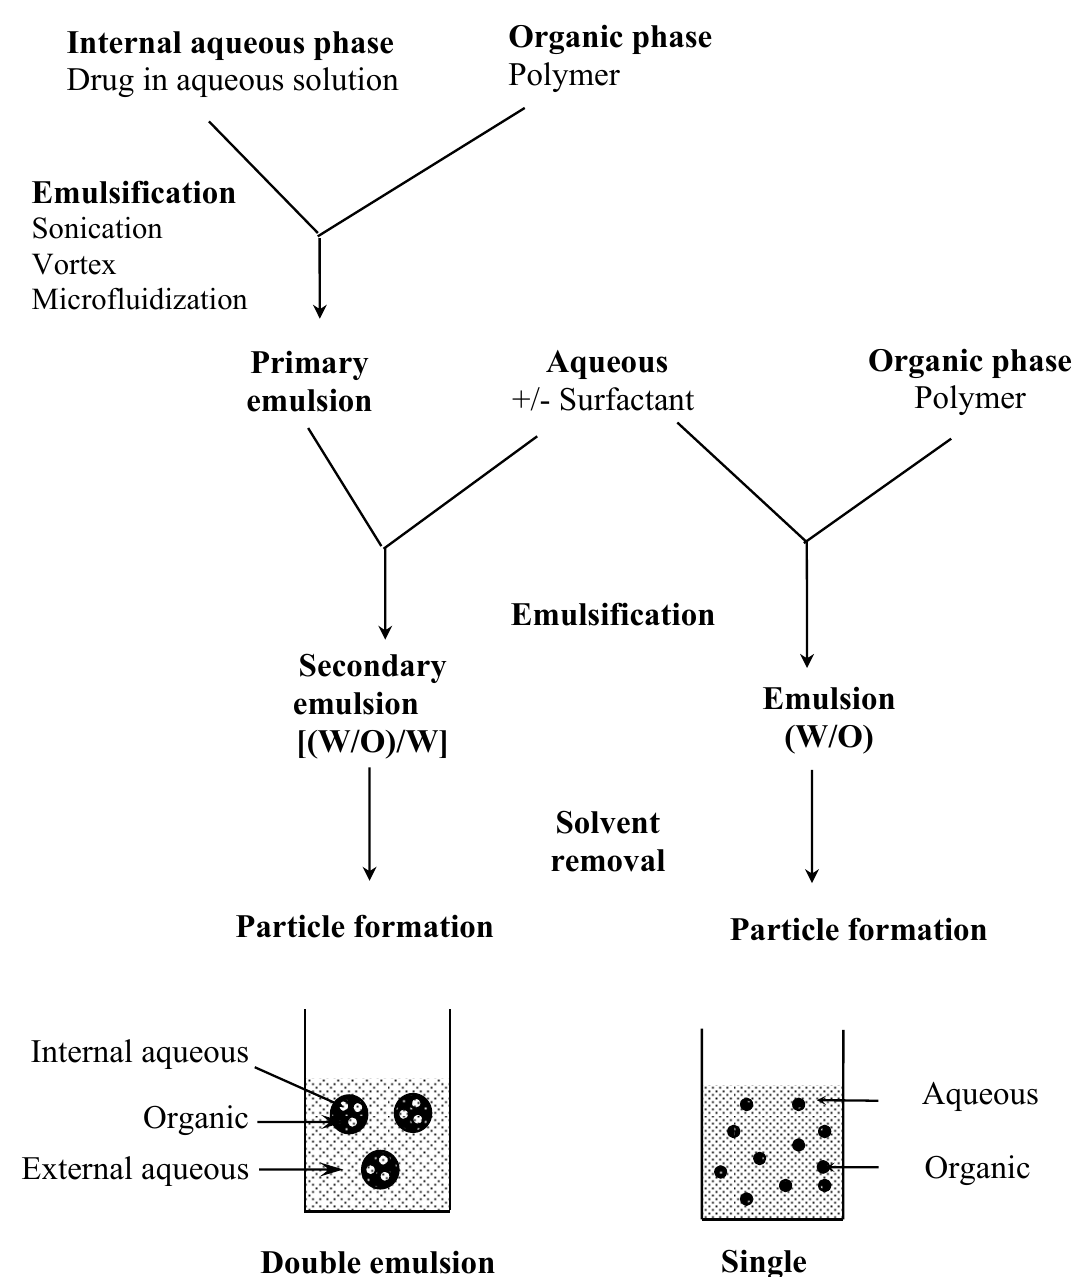
Figure 2 : Particle preparation methods by polymer precipitation, examples of single and double emulsion